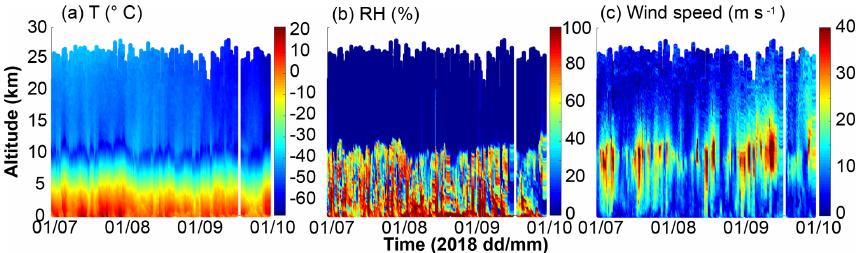
Figure 10. POPEYE radiosonde data, including time–height cross sections of (a–c) temperature, relative humidity and wind speed as observed during the second YOPP Special Observing Period.